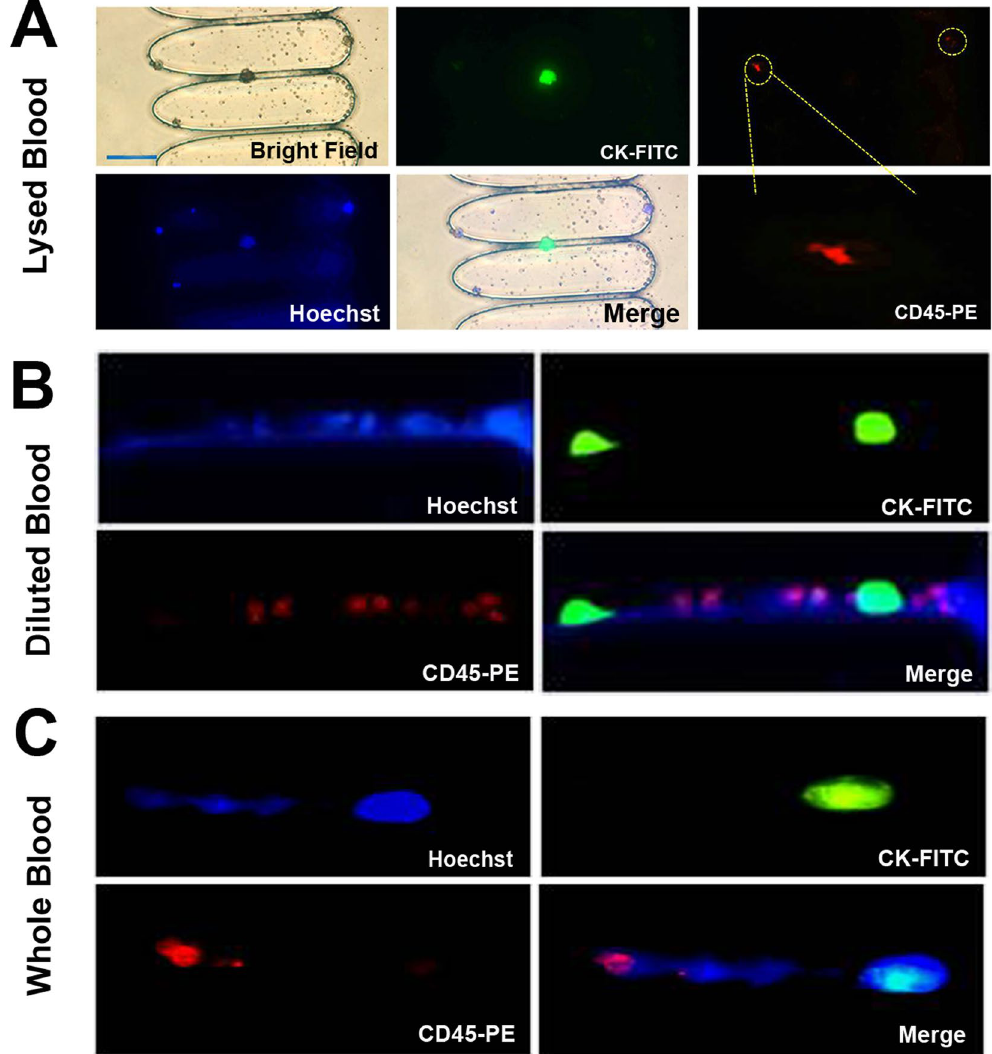
( C ) artificial whole patient blood. Scale bar = 50 µ